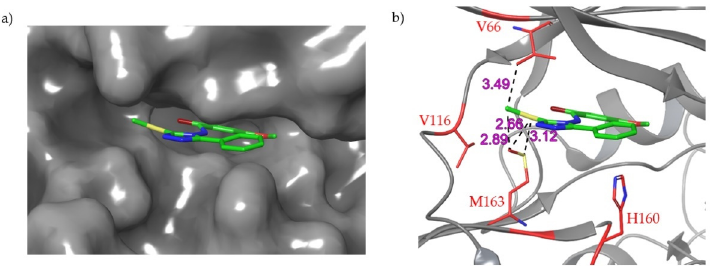
Figure 9. Binding mode of GO289 with CK2 α and key interactions between the inhibitor and the ATP-site. ( a ) Structure of GO289 bound in the ATP-site of CK2 α (PDB: 6A1C). ( b ) Interactions between CK2-specific residues and GO289. The key interacting residues are shown in red, namely H160, M163, V116 and V66. Hydrogen bond lengths are given in